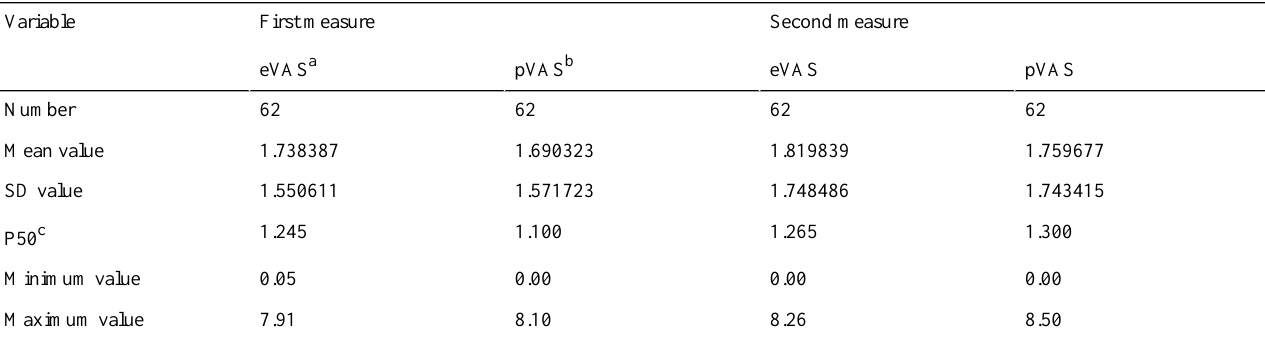
Table 2. Summary statistics (visual analog scale measurements) for